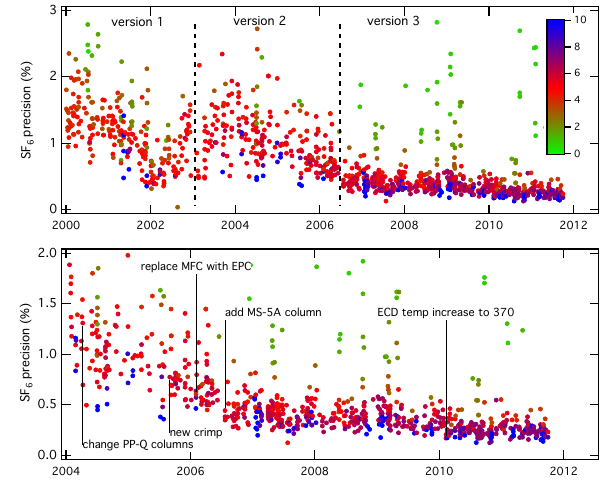
Fig. 4. History of SF 6 precision (%) from all samples analyzed Figure 4: History of SF 6 precision (%) from all samples analyzed on the GC-ECD systems used 538 on the GC-ECD systems used for calibrations (color-coded by SF 6 for calibrations (color-coded by SF 6 mole fraction (ppt)). Upper plot shows three GC versions. 539 mole fraction – ppt). Upper plot shows three GC versions. Lower Lower plot shows versions 2 and 3 along with system changes. 540 plot shows versions 2 and 3 along with system